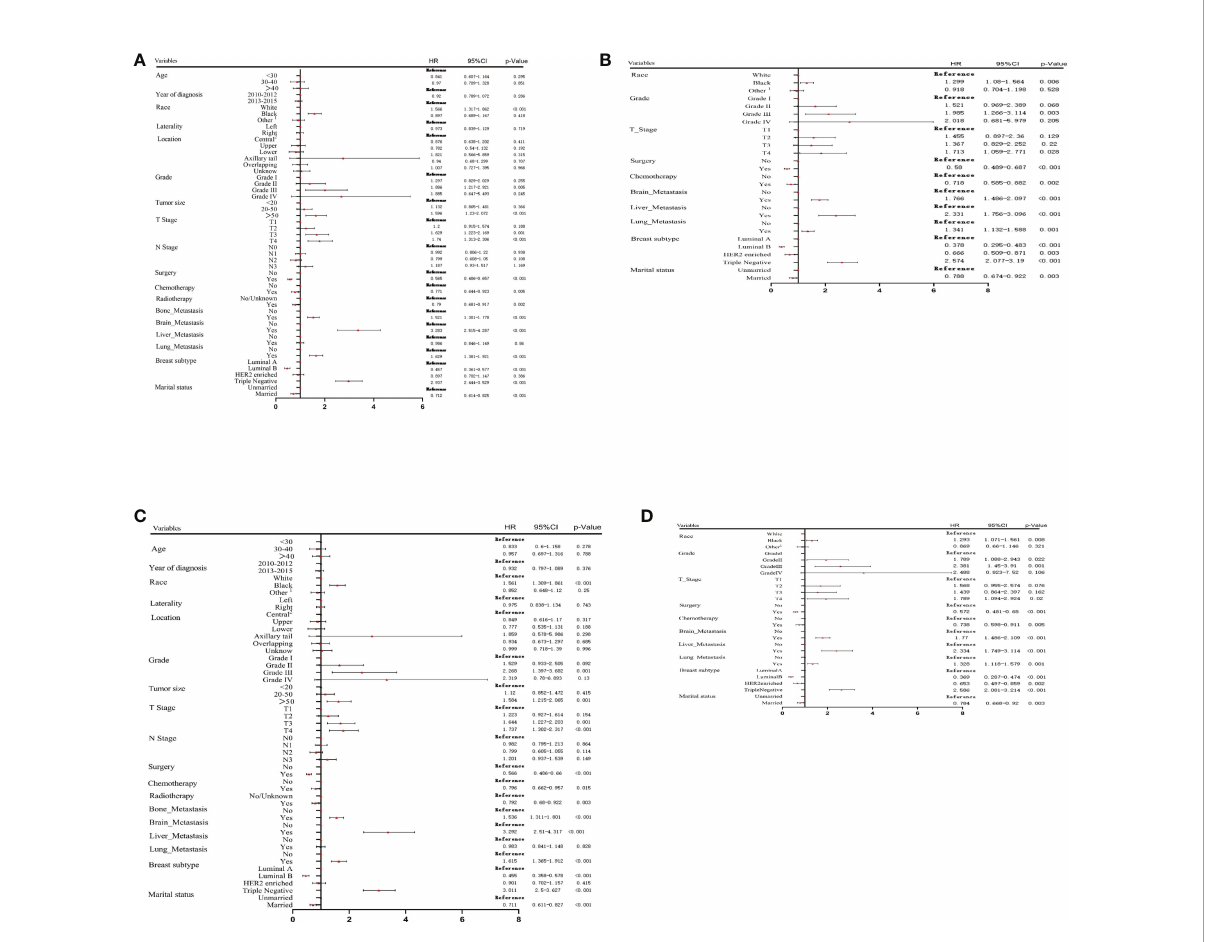
FIGURE 2 Univariate (A) and multivariate (B) Cox proportional hazards regression analysis of OS in the training cohort. Univariate (C) and multivariate (D) Cox proportional hazards regression analysis of CSS in the training cohort. 1: American Indian/AK Native, Asian/Paci fi c Islander; 2: central portion of breast or